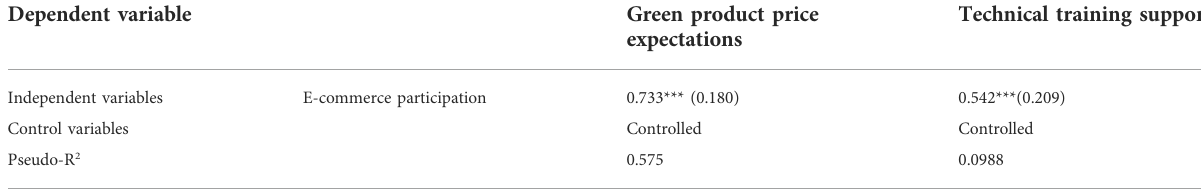
TABLE 5 Correlation between e-commerce participation and green agrotechnology adoption support elements for resettled households.